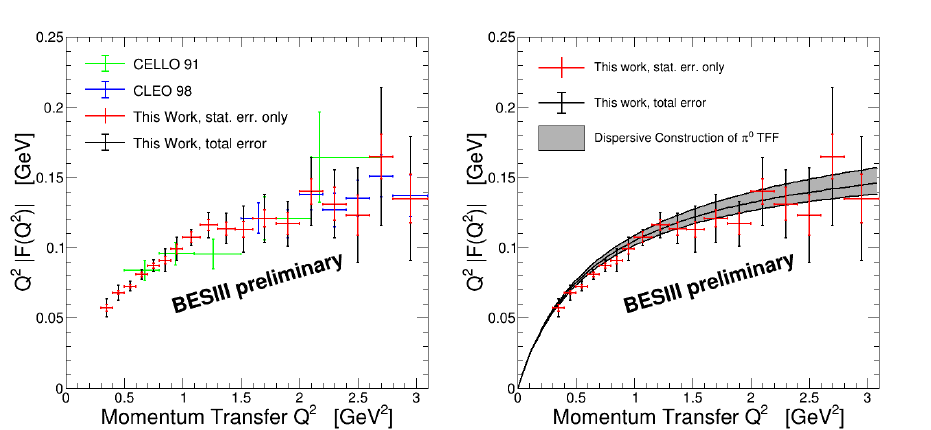
Figure 1. Preliminary result of the π 0 TFF from BESIII (red: statistical uncertainty; black: total uncer- tainty). Left: The results of the CELLO [25] and CLEO [26] Collaborations are shown for comparison. Right: The dispersive construction of the π 0 TFF [21] is confronted with the preliminary